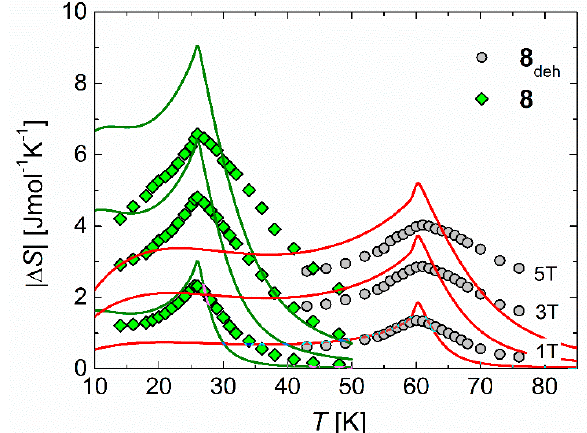
Figure 23. Isothermal entropy change extracted from the experiment (symbols) and calculated within the framework of the molecular field approximation (solid lines) for {Mn II2 (imH) 2 (H 2 O) 4 [Nb IV (CN) 8 ]·4H 2 O} n and its dehydrated form {Mn II2 (imH) 2 [Nb IV (CN) 8 ]} n .